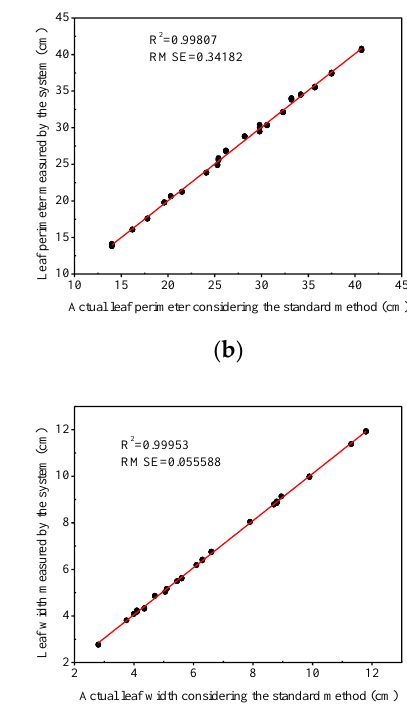
Figure 10. The relationship between the relative errors of the leaf areas measured by the system and the grid method.